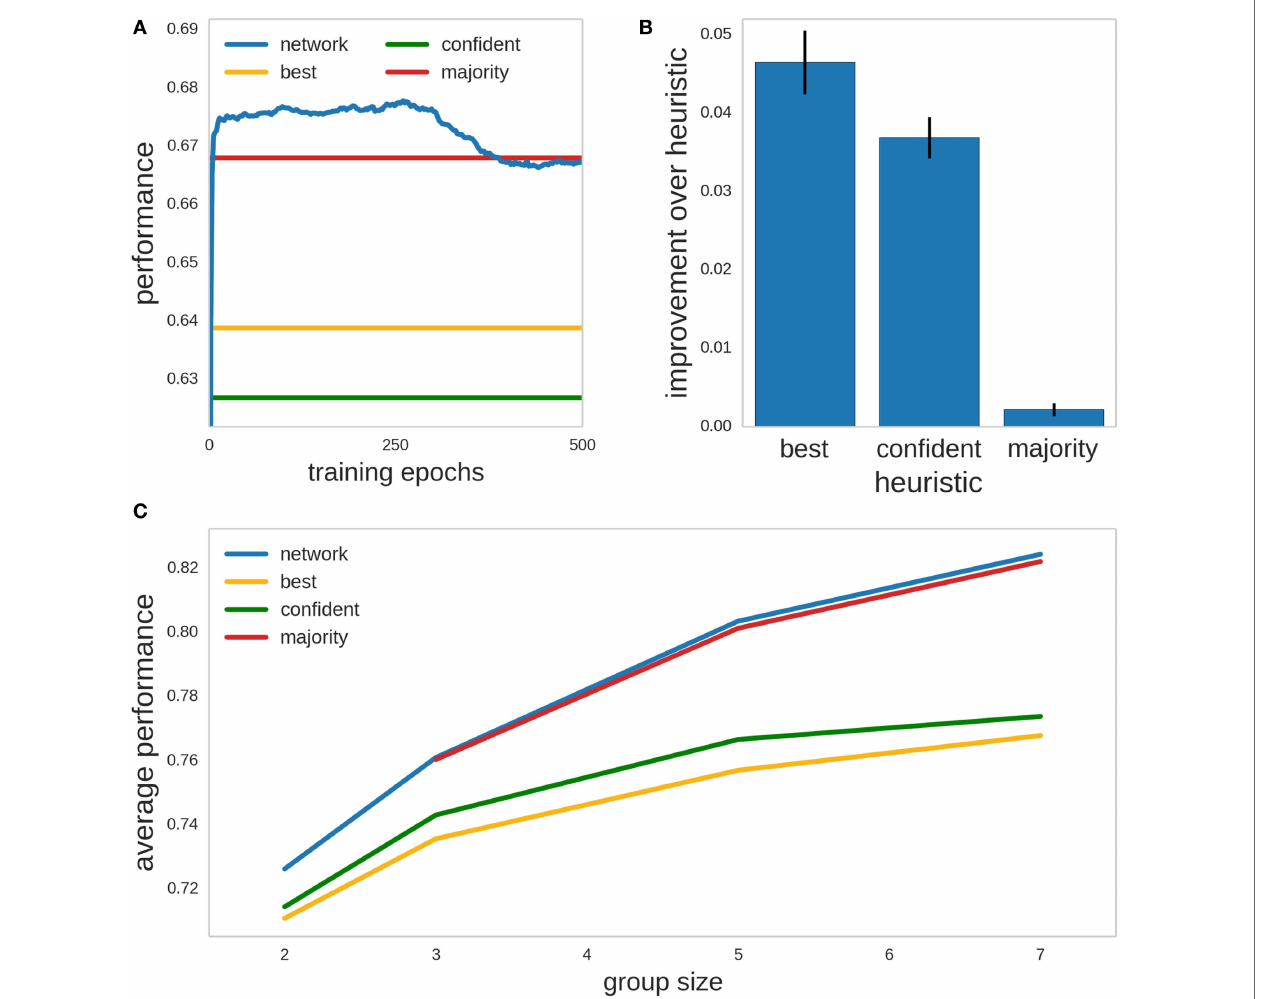
FIGURE 7 | Network learning how to combine the opinions and confidence scores of three doctors into a cancer/no cancer classification rule. (A) Example of the training of one network for a particular partition of the data into 50% for training and 25% each for validation and test, for groups of 5 doctors. Shown is the evolution of the performance for the test data (Youden’s index, J = sensitivity + specificity (cid:0) 1) of the network (blue line), and the performance of the best doctor heuristic (yellow line), the more confident heuristic (green line), and the majority heuristic (red line). (B) Mean improvement in Youden’s index of the network over the heuristics for groups of 5 doctors. Error bars are SEM. (C) Average performance of network and heuristics over all the validation sets, for groups of 2, 3, 5, and 7 doctors. Colors as in panel (A) .